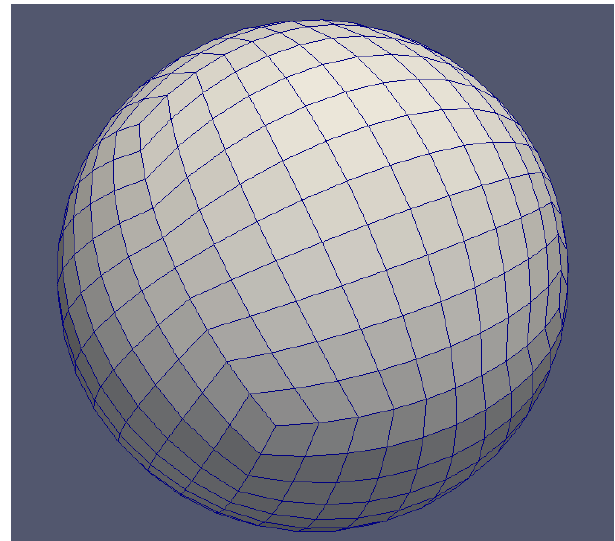
Figure 2. Example of a cubed-sphere quadrilateral mesh with n e = 10 (3 ◦ resolution), yielding 600 elements.